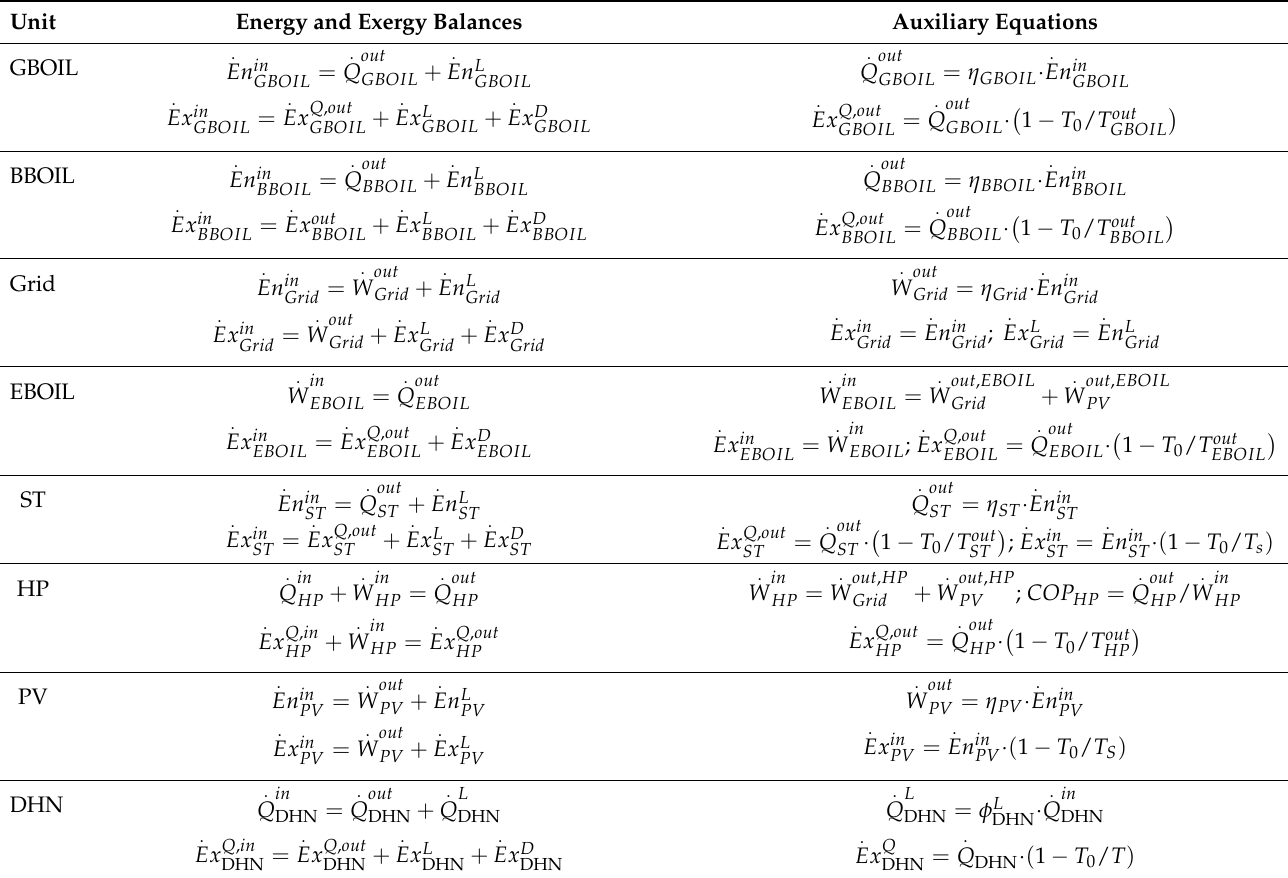
Table A3. Specific formulation of unit-by-unit energy and exergy balances and auxiliary equations. Unit Energy and Exergy Balances Auxiliary